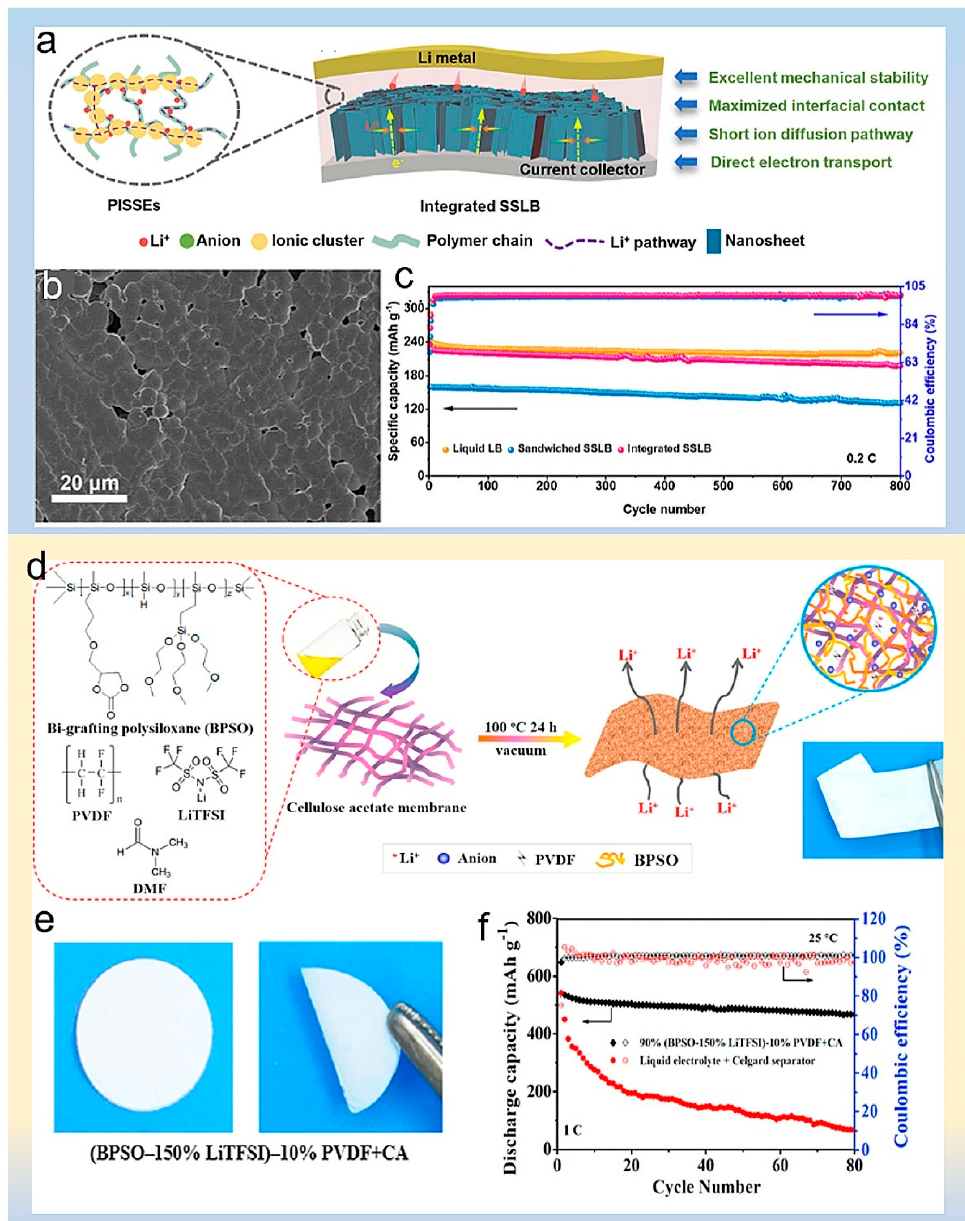
Figure 10. ( a ) Illustration of Li ion transport pathways in PISSEs. ( b ) SEM image of the PVHLi-1.1 membrane. ( c ) Cycling performance at 0.2 °C. Reproduced with permission [89]. Copyright 2021, John Wiley and Sons. ( d ) Schematic illustration of fabricating composite polymer electrolyte membrane by solution-casting technique. ( e ) Optical photo of 90% (BPSO-150% LiTFSI)-10% PVDF + CA membranes. ( f ) Cycling performance of all-solid-state MCNT@S|90% (BPSO-150% LiTFSI)-10% PVDF + CA|Li cells at 25 °C 1 C rate [93]. Reproduced with permission. Copyright 2018, Elsevier.